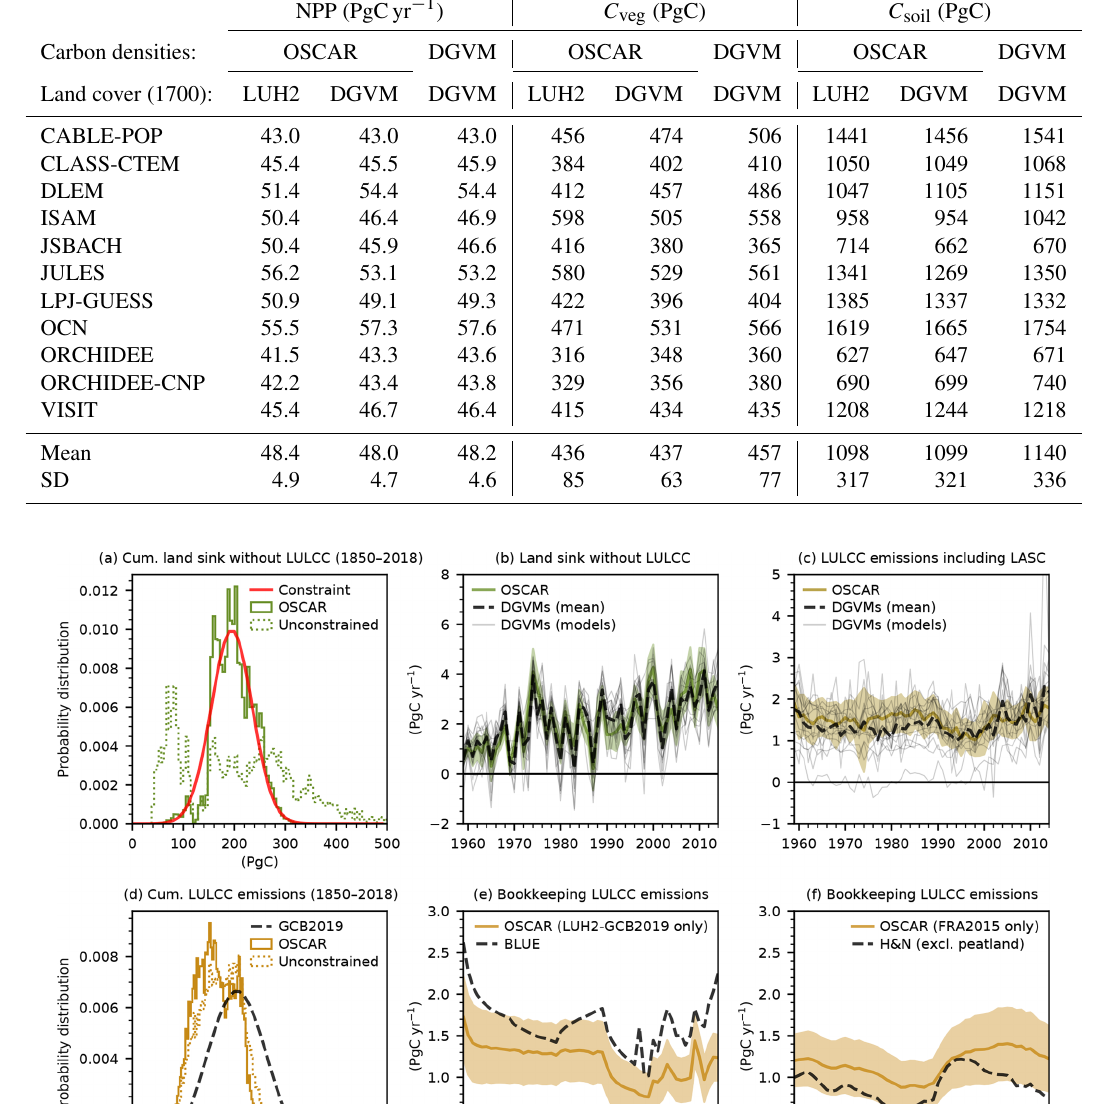
Table A1. Preindustrial NPP and carbon stocks in GCB2018 DGVMs and in their emulation by OSCAR. The “DGVM” columns show the carbon fluxes or stocks we extracted for the calibration of OSCAR. Because we used our own land area map and regional mask to process the original DGVM outputs and then aggregated regional values into global values, these values may slightly differ from a direct extraction of the DGVM outputs. The GCB2018 protocol did not require the DGVM teams to provide their own land area map.